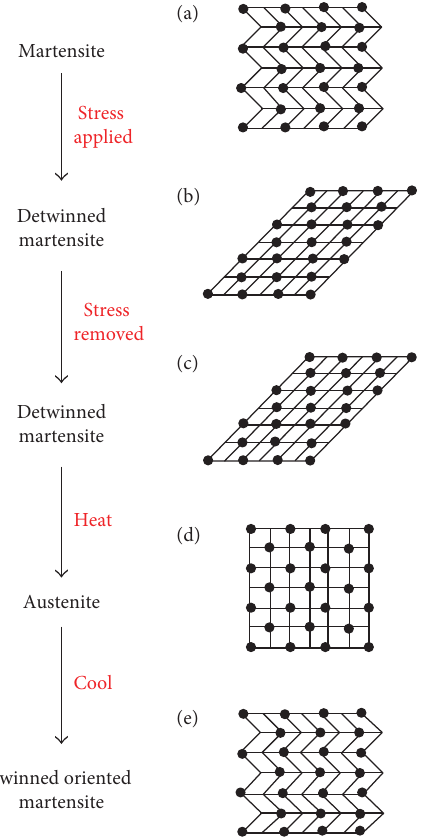
Figure1:Mechanismofshapememoryeffectwhentesttemperature is below 𝑀 𝑓 . (a) Martensite at test temperature. (b) Detwinned martensite upon application of stress. (c) Detwinned martensite upon removal of stress. (d) Austenite upon heating above 𝐴 𝑓 . (e) Martensite upon cooling below 𝑀 𝑓 (test temperature). Change in lattice structure with phase transformation is given in Figure 8 of [6].